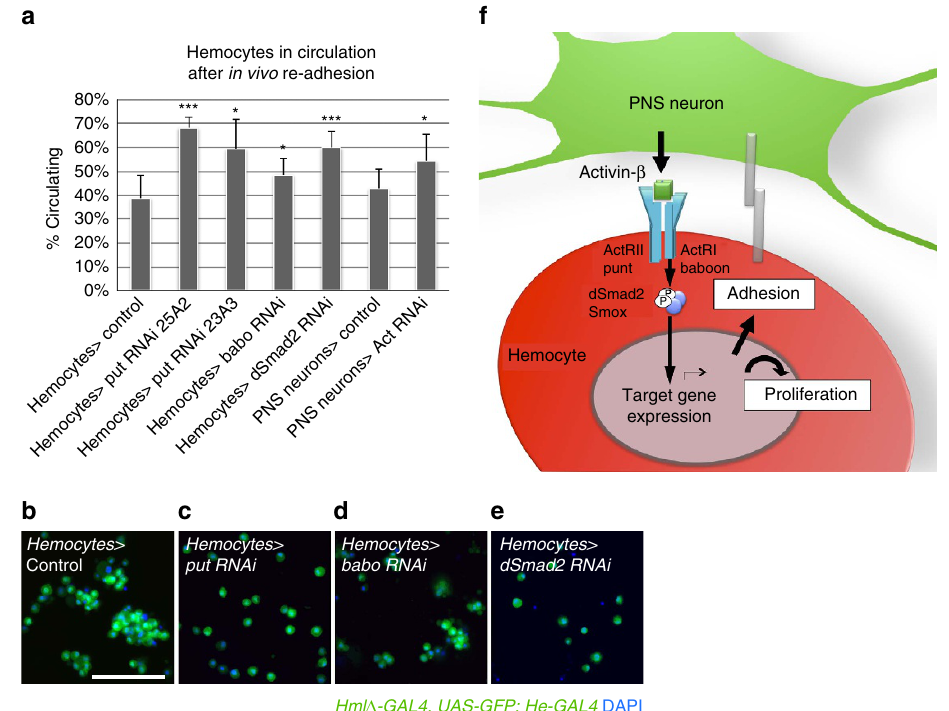
Figure 4 | Activin- b promotes hemocyte adhesion. ( a ) In vivo re-adhesion of hemocytes after mechanical disturbance, bars illustrate percent of circulating hemocytes; genotypes are Hml D -GAL4, UAS-GFP; He-GAL4 (cid:3) UAS-RNAi transgenes and control; and 21-7-GAL4, UAS-mCD8GFP, Hml D -DsRed (cid:3) UAS- Act b RNAi and control; n ¼ 7 to 8. ( b – e ) Ex vivo released hemocytes show different levels of aggregation; Hml D -GAL4, UAS-GFP; He-GAL4 (cid:3) ( b ) Control; ( c ) UAS-put RNAi; ( d ) UAS-babo RNAi; ( e ) UAS-dSmad2 RNAi. ( f ) Model of Act b production by sensory neurons and induction of hemocyte responses in proliferation and adhesion. Scale bars, b , 50 m m. Error bars represent s.d., and two-tailed t -test values correspond to NS (not significant) P 4 0.05; * P r 0.05; ** P r 0.01; *** P r 0.001; **** P r